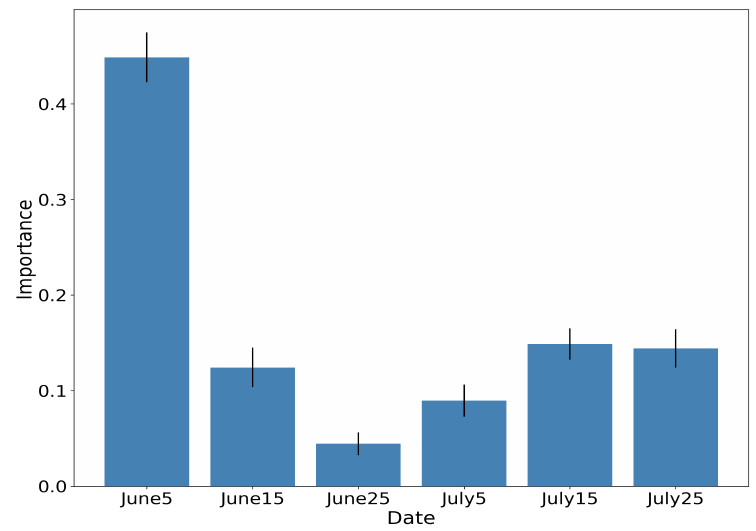
Figure 16. RF importances aggregated by time-step of the interpolated time-series, along with the respective standard deviation for 10 different runs.